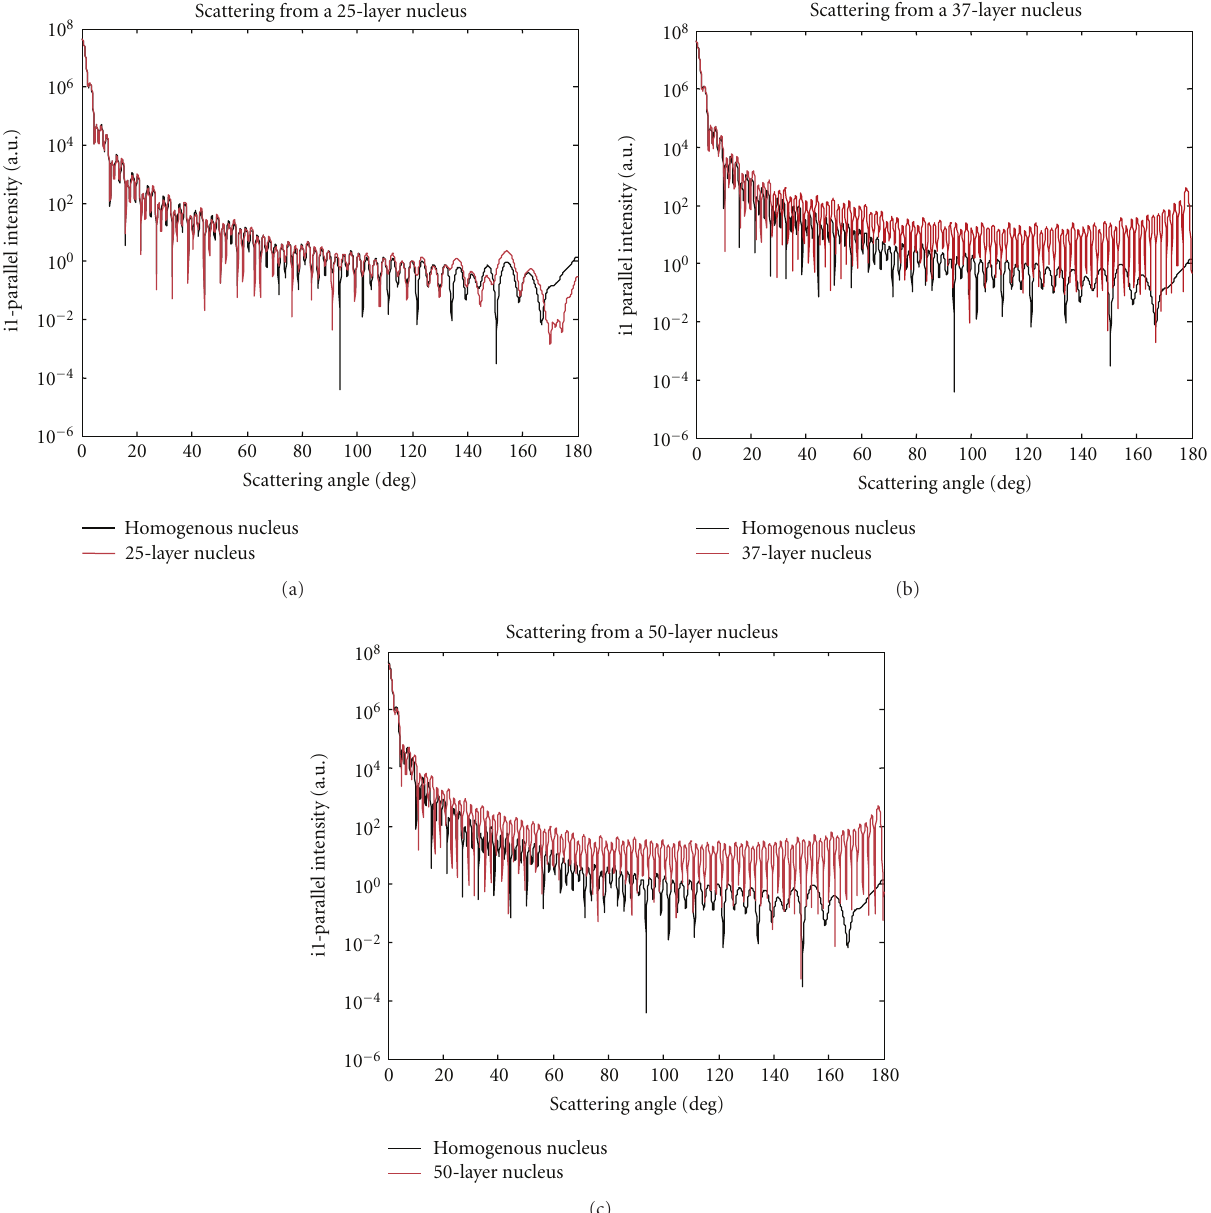
Figure 7: (a) Parallel component of the scattered intensity i 1 as a function of the scattering angle for a nucleus with refractive index fluctu- ations (layers) of 5 cycles/micron spatial frequency. (b) Parallel component of the scattered intensity i 1 as a function of the scattering angle for a nucleus with refractive index fluctuations of 7.5 cycles/micron spatial frequency. (c) Parallel component of the scattered intensity i 1 as a function of the scattering angle for a nucleus with refractive index fluctuations of 10 cycles per micron spatial frequency.